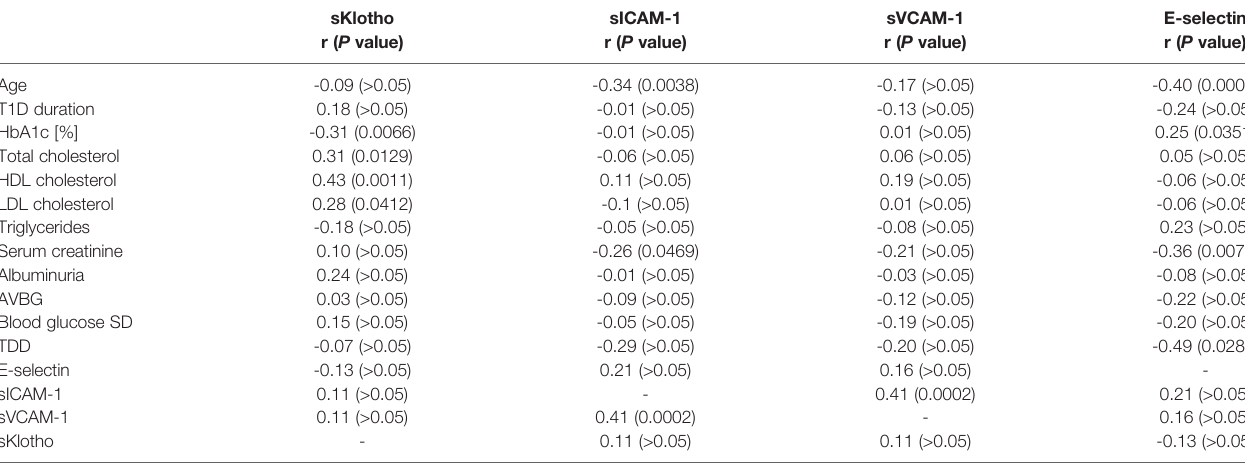
TABLE 3 | Spearman rank correlation coef fi cients between sKlotho protein, studied adhesion molecules and selected risk factors in children with type 1 diabetes. sKlotho